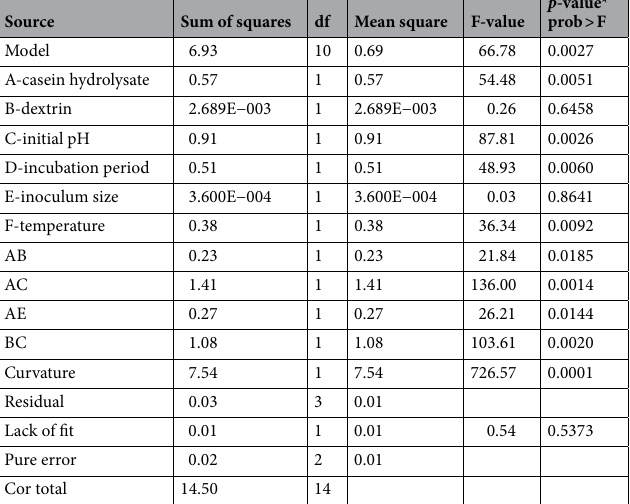
Table 6. Analysis of variance (ANOVA) of PBD for AuNPs biosynthesis, using the extracellular filtrate of Bacillus subtilis NRC1. F value = 66.78; R 2 = 0.99; Adjusted R 2 = 0.98. *: Values of "prob > F" less than 0.05 indicate model terms are significant.